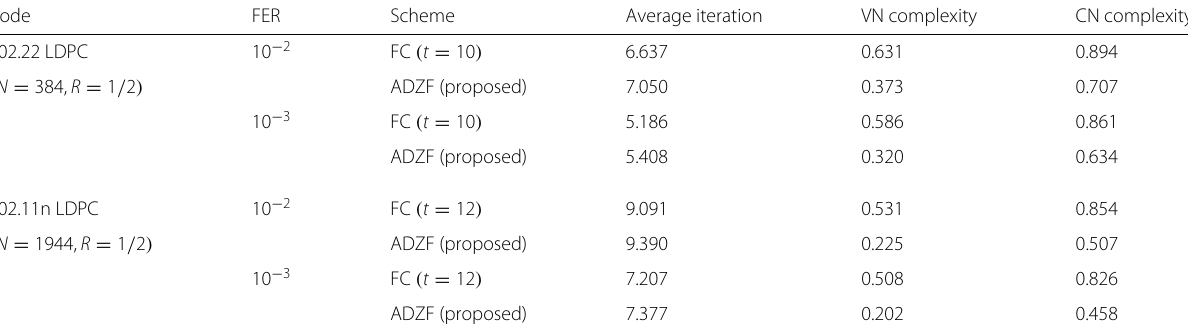
Table 1 Simulation results of the FC scheme and proposed ADZF scheme when 802.22 LDPC codes and 802.11n LDPC codes are used Code FER Scheme